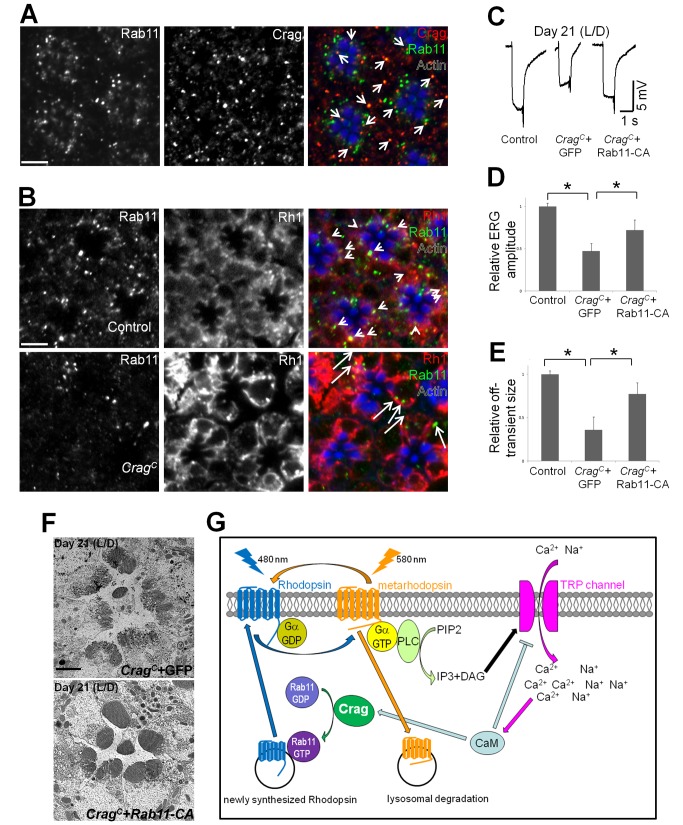
Crag genetically interacts with Rab11 in vivo.(A) Immunostaining of Crag (green) and Rab11 (red) in cross-sections of wild-type photoreceptors upon 12 h of light stimulation. The proteins colocalize in punctuate structures (indicated by arrowheads). The rhabdomeres are marked by Actin staining (blue). Scale bar, 5 µM. (B) Immunostaining of Rab11 (red) and Rh1 (green) in photoreceptors of wild-type controls and Crag mutants upon 12 h of light stimulation. In controls, Rab11 is present in punctae that partially colocalize with Rh1 (indicated by arrowheads), and most of the punctae are close to the rhabdomeres; in Crag mutants, many fewer punctae of Rab11 are observed, and these punctae are not closely associated with rhabdomeres (indicated by arrows). Scale bar, 5 µM. (C) GFP or Rab11-CA were expressed in Crag mutant clones, and the flies were kept in a 12 hour light/dark cycle (L/D) for 3 wk along with controls (y w P{neoFRT}19Aiso with GFP expression in the photoreceptors). Representative ERG traces of these flies are shown. (D) Quantification of the ERG depolarization amplitudes shown in (B). Ten ERG traces were measured for each genotype at each time point. An asterisk indicates a p-value less than 0.05. (E) Quantification of the ERG off-transient amplitudes shown in (B). Ten ERG traces were measured for each genotype at each time point. (F) TEM of photoreceptor cross-sections of flies expressing GFP or Rab11-CA in Crag mutant photoreceptor cells after 21 d of incubation in a light/dark cycle. The morphology of the rhabdomeres is much better preserved when Rab11-CA is expressed. Scale bar, 1 µM. (G) Model of Crag function. Upon absorption of a photon, Rh1 undergoes a conformational change to the active form, metaRh, which signals through a G-protein-coupled cascade and triggers the opening of TRP channels and the influx of Ca2+ and Na+ into photoreceptor cells. MetaRh is converted back into Rh1 by exposure to another photon. However, a subpopulation of Rh1 is endocytosed and degraded through a lysosomal pathway. To replenish the Rh1 pool, Rh1 needs to be synthesized and delivered to the rhabdomeres. Rab11-mediated vesicle trafficking is required for Rh1 transport to the rhabdomeres. Crag is a GEF for Rab11 in this process, and its GEF activity maybe enhanced by CaM and Ca2+ influx. Hence, light stimulation not only triggers endocytosis but may also promote trafficking of Rh1 to rhabdomeres to maintain homeostasis. PLC, Phospholipase C.